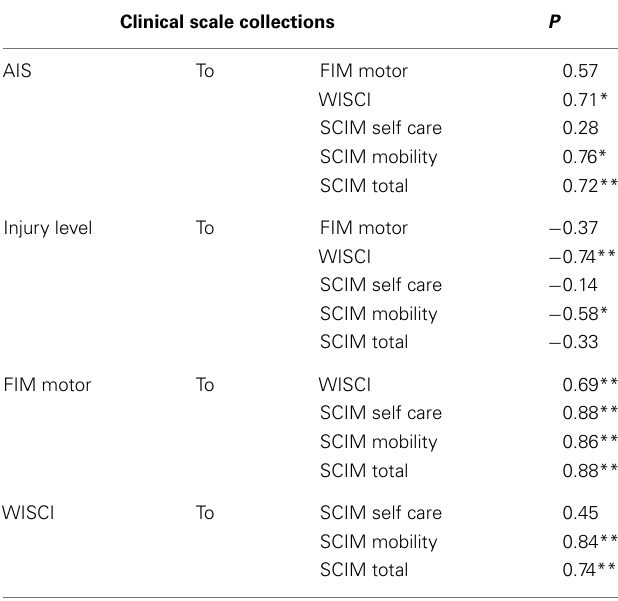
Table 2 | Spearman’s rank correlation rho ( ρ ) values comparing across clinical scale